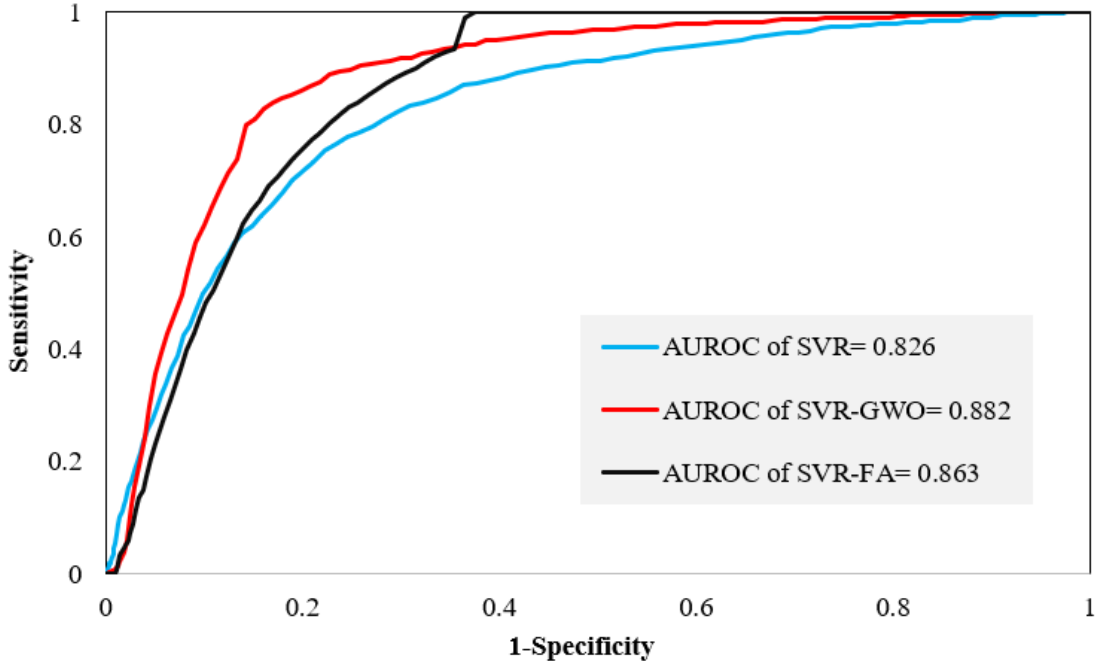
Figure 10. Area under the receiver operating characteristic curve (AUROC) curves of hybrid models using the training dataset.